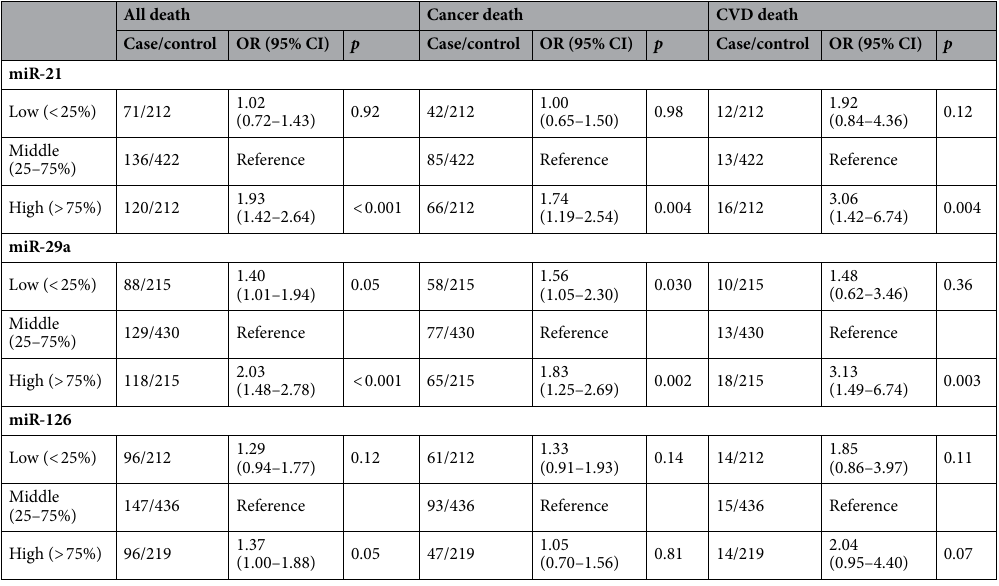
Table 2. Age- and sex- adjusted ORs and 95% CIs for premature death with respect to the three categories of serum miRNAs levels. Adjustment for sex, age, study site, systolic blood pressure, body mass index, smoking status, drinking status, leisure time activity, and educational level. CVD cardiovascular